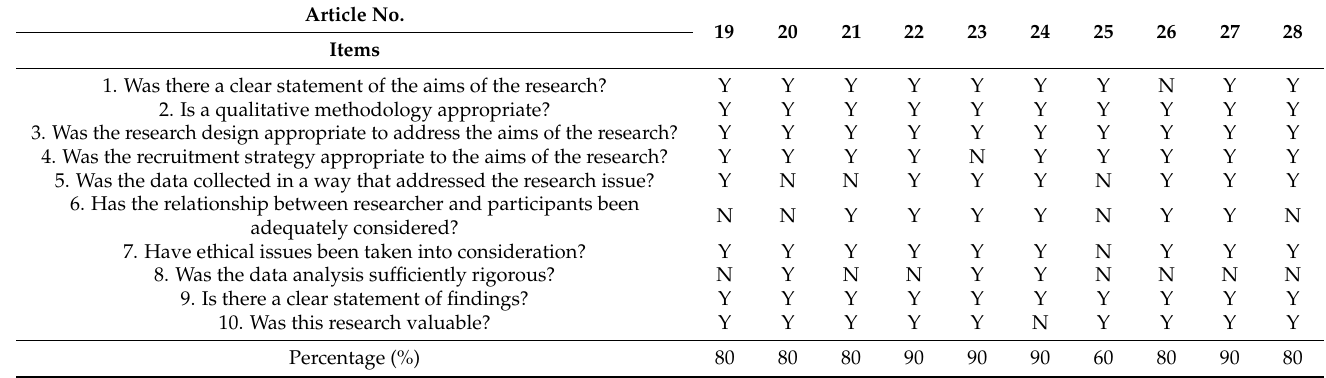
Table 1. Quality assessment result of the critical appraisal screening program using studies included. Article